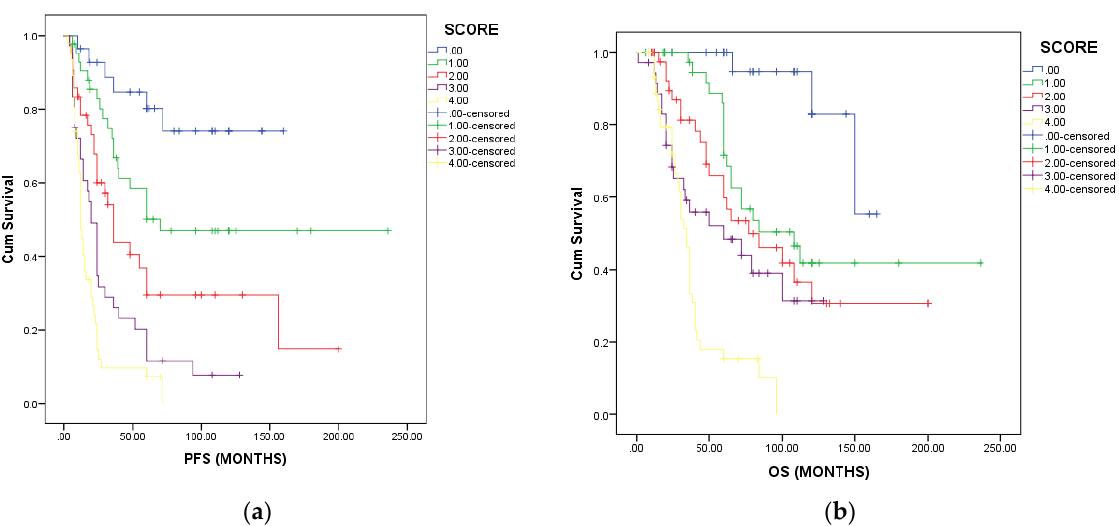
Figure 2. Progression-free survival ( a ) and overall survival ( b ) according to the number of risk fac- tors.